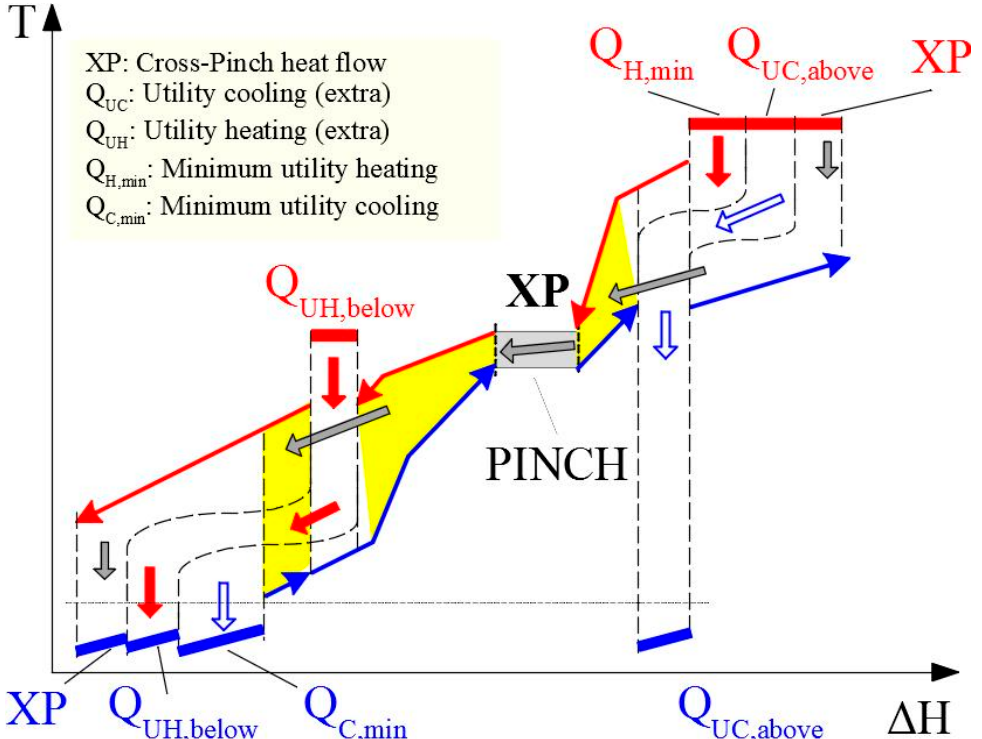
Figure 9. Pinch Methodology in energy targeting (adapted from Klemeš et al. [59]).